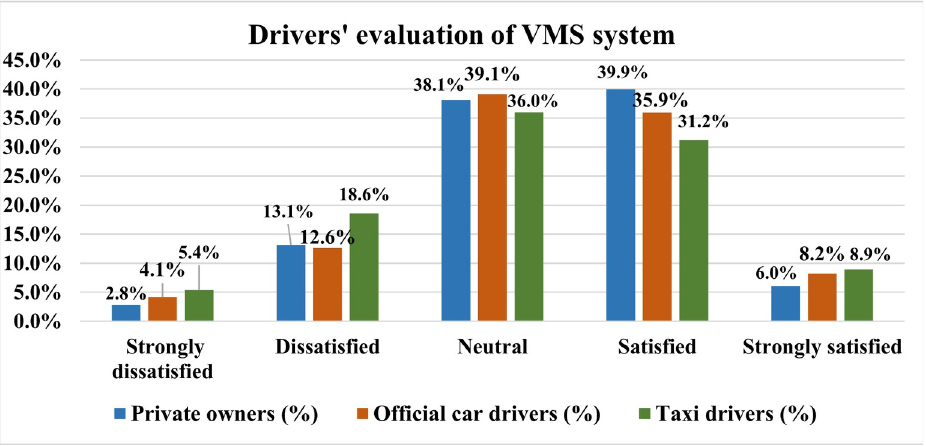
Fig 4. Proportional distribution of perceived quality of service by different types of